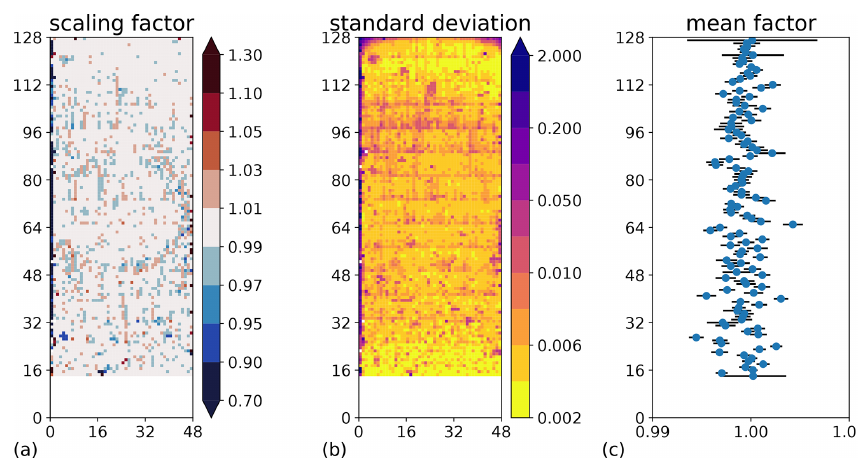
Figure 5. The estimated error in the gain, as derived from the homogeneity of 158 atmospheric spectra. Panel (a) : residual scaling factors for each pixel. Differences from one denote the estimated error. Panel (b) : the corresponding standard deviation of the variability over the same atmospheric spectra. Panel (c) : the estimated error in the gain after averaging over all pixels in a row (excluding the leftmost two and the rightmost columns). All atmospheric spectra were cloudy in the lowermost rows, precluding an analysis.